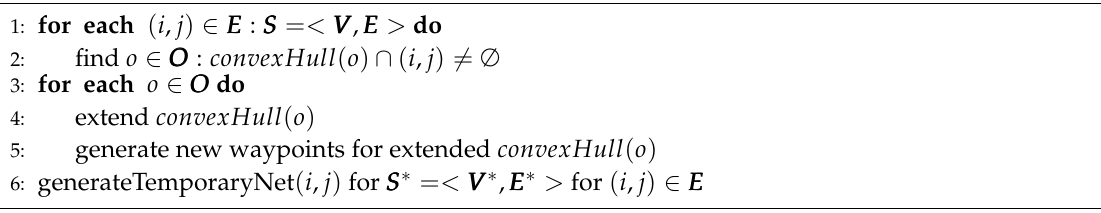
Algorithm 3 Algorithm for graph construction to avoid obstacles